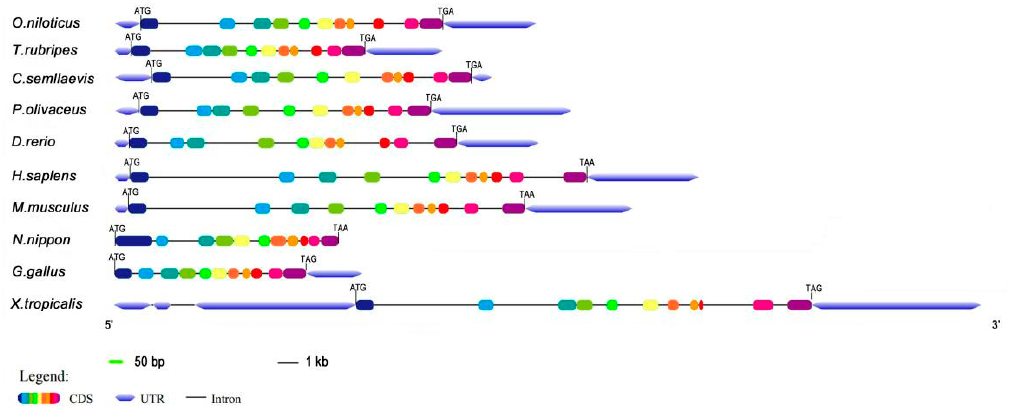
Figure 2. Gene structure of the P. olivaceus calb 2 and its counterparts from other vertebrates. The color frame and black line represent exons and introns, respectively. ATG and TAG (TGA, TAA) indicate a start and stop codon, respectively.